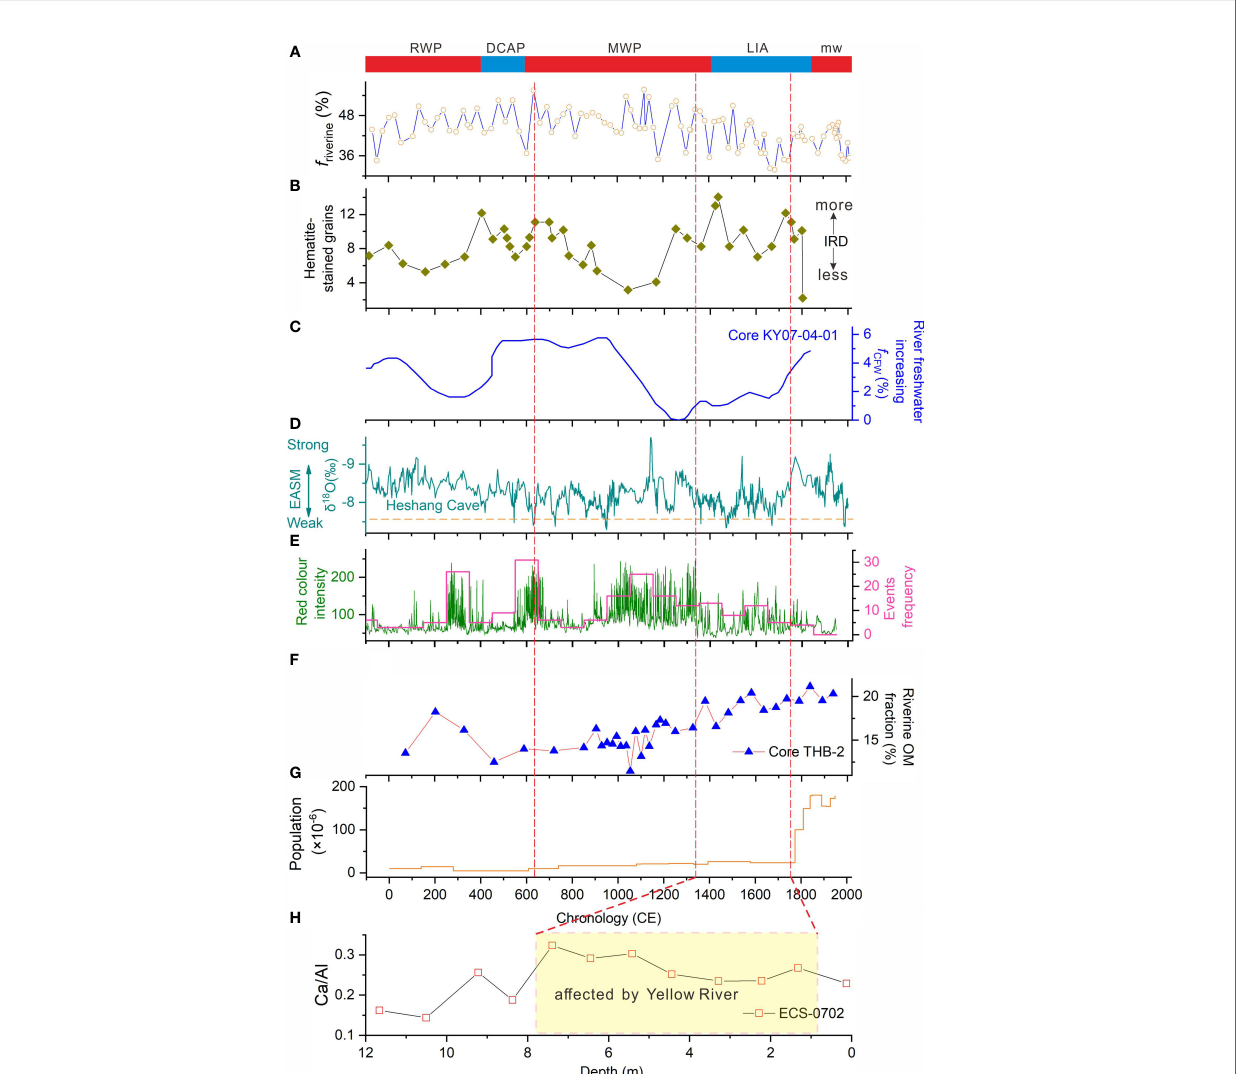
FIGURE 7 | ( A ) Fractional variations (%) in riverine OM in Core C2. (B) stacked IRD index (hematite-stained grains) in the North Atlantic (Bond et al., 2001) (C) Proportion of YR freshwater to the northern ESC over the last 2000 yr (Kubota et al., 2015). (D) d 18O records of stalagmites from Heshang Cave (Hu et al., 2008). (E) ENSO activity recorded by sedimentation at Laguna Pallcocha, Ecuador (Moy et – al., 2002). (F) fractional variations in riverine OM of core THB-2 from the Min- Zhe coastal mud area of the East China Sea. (G) population variation in the YR basin (Zhang et al., 1994). (H) The Ca/Al ratio variations of core ECS-0702 (Liu et al., 2010) Dashed lines mark evolutionary stage divisions as discussed in Section